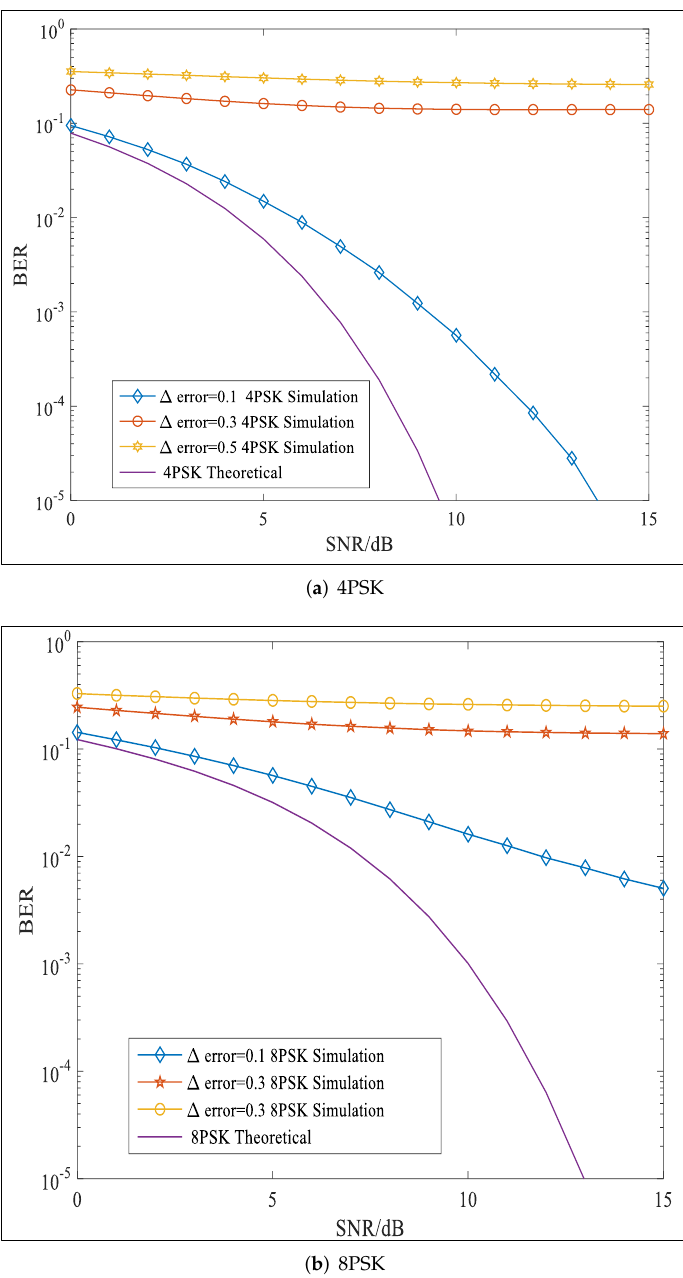
Figure 7. BER performance of the PPF-OM scheme with errors in